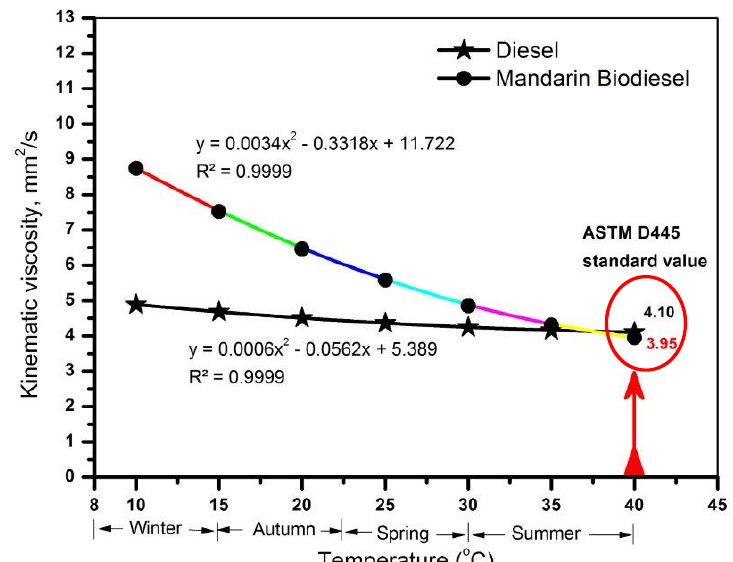
Figure 11. Variation of kinematic viscosity with temperature.